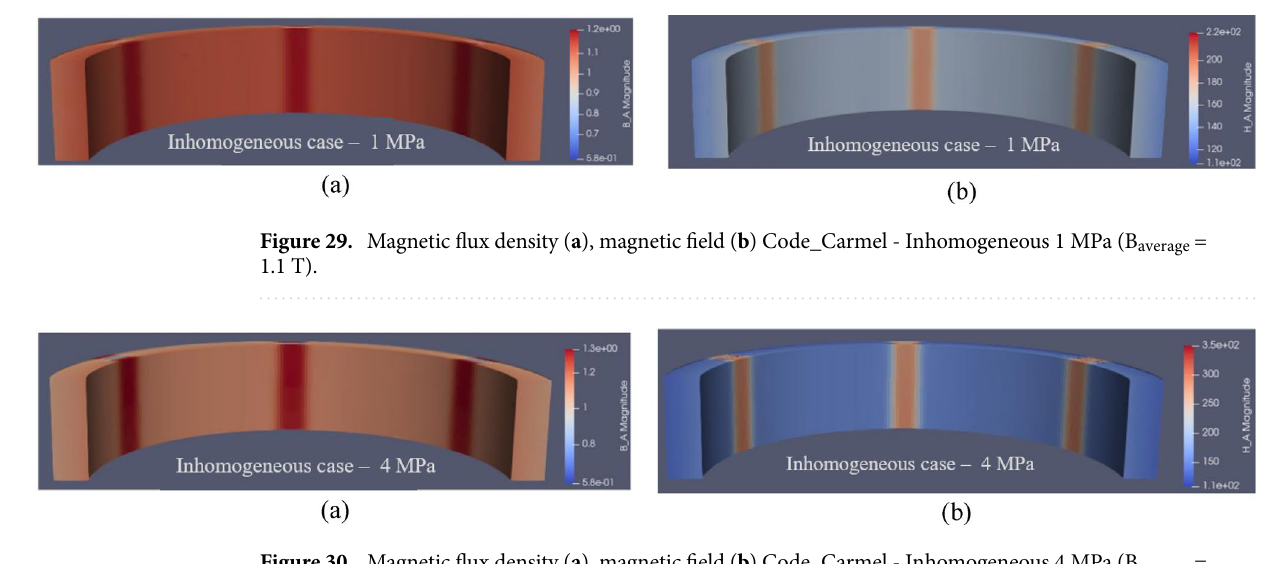
Figure 30. Magnetic flux density ( a ), magnetic field ( b ) Code_Carmel - Inhomogeneous 4 MPa ( B average = 1.1 T).